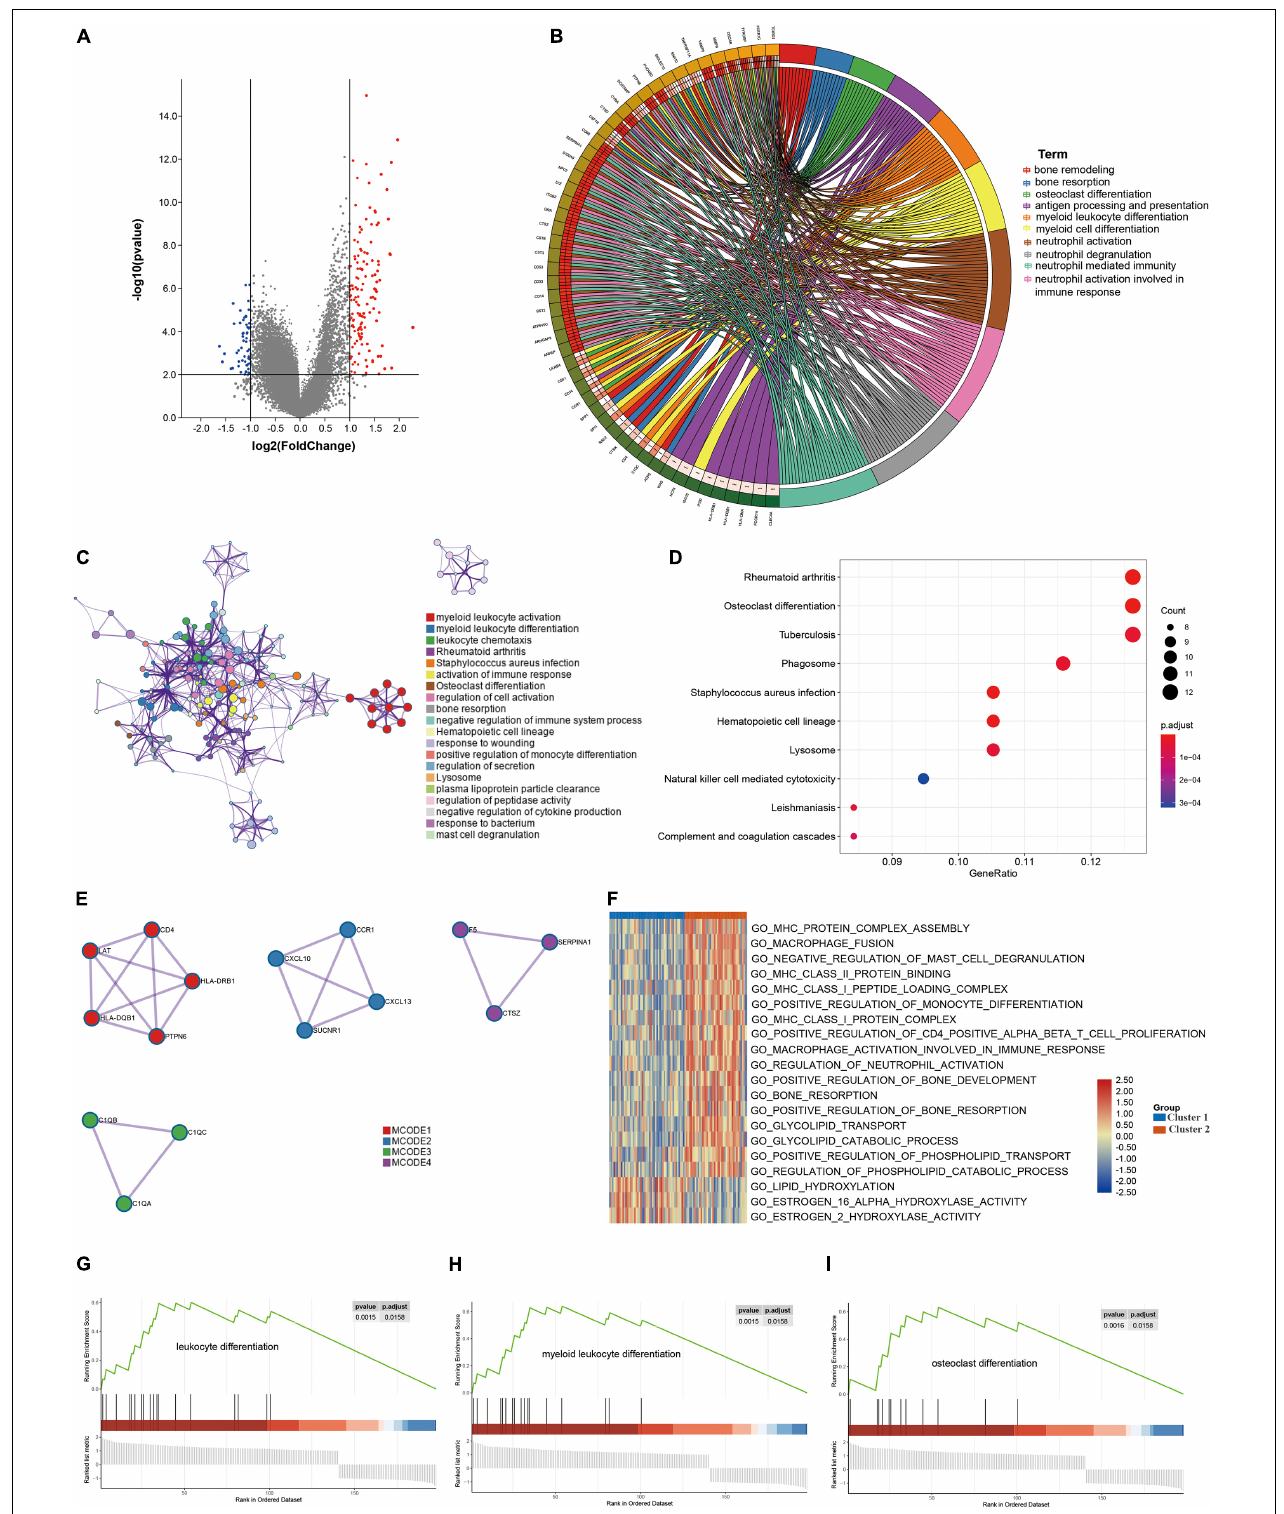
FIGURE 4 | Differentially expressed genes (DEGs) analysis and functional analyses. (A) Volcano plot showing the DEGs between the two subgroups, (B,C) circle plot and network visualizing the biological processes enriched by gene ontology (GO) analysis, (D) bubble diagram showing the signaling pathways enriched by Kyoto Encyclopedia of Genes and Genomes (KEGG) analysis, (E) PPI analysis of DEGs, (F) heatmap illustrating the result of GSVA analysis, (G–I) GSEA plots visualizing the result of GSEA analysis.